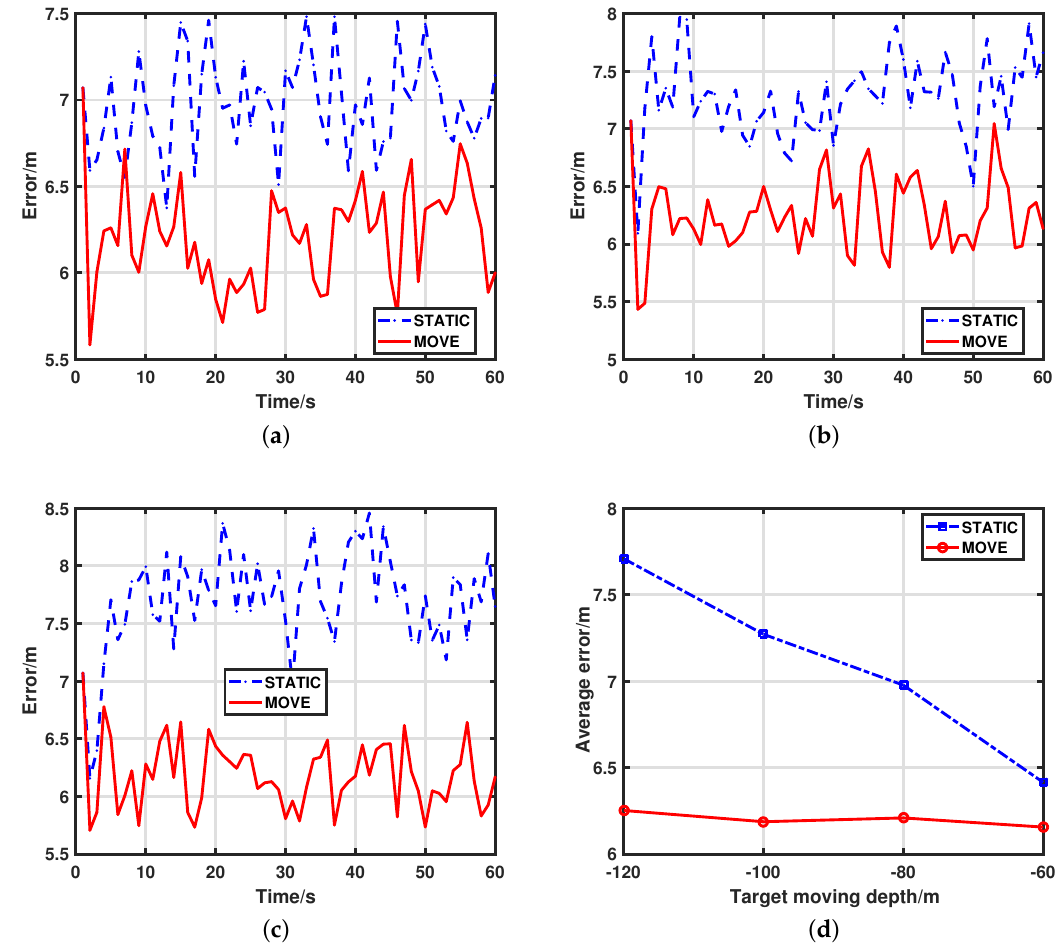
Figure 3. The tracking error comparison between MOVE and STATIC with different moving depths. ( a ) tracking errors for MOVE and STATIC with moving depth h = − 80 (over 100 MC runs); ( b ) tracking errors for MOVE and STATIC with moving depth h = − 100 (over 100 MC runs); ( c ) tracking errors for MOVE and STATIC with moving depth h = − 120 (over 100 MC runs); ( d ) average tracking errors for MOVE and STATIC with different moving depths (over 100 MC